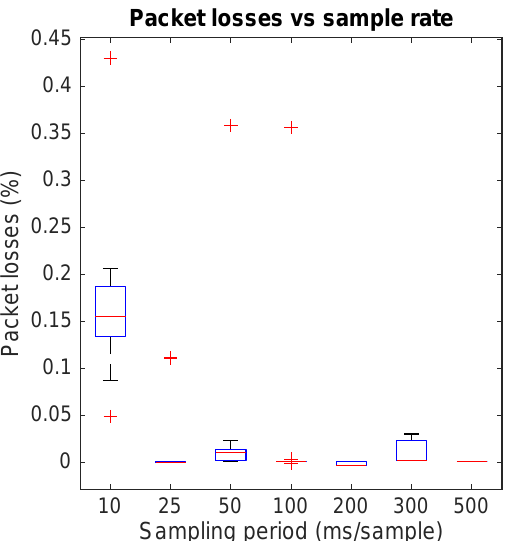
Figure 10. Packet loss ratio versus tested sampling periods.